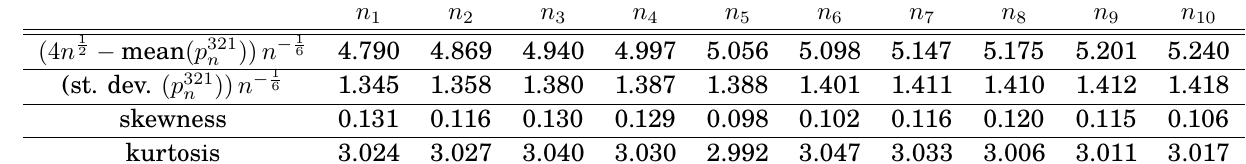
Table 1: Monte Carlo simulation results for two-aligned segments for 10 logarithmically spaced n values from 10 4 to 10 7 .